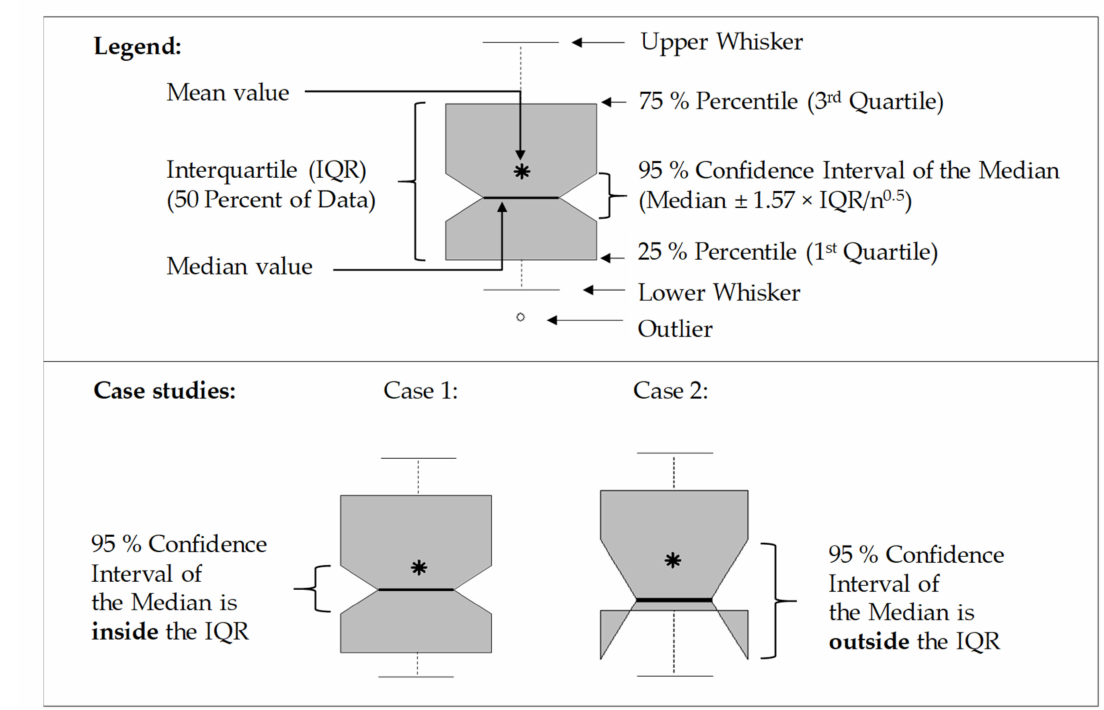
Figure A1. Elements of a Boxplot with notches including case studies.